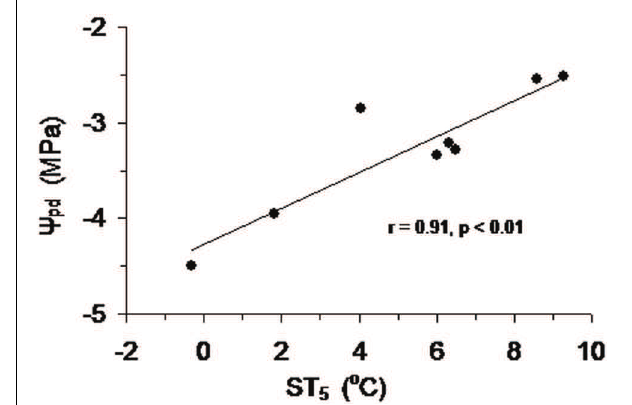
FIGURE 7 | Seasonal variation of predawn leaf water potential ( (cid:57) pd ) of Smith fir trees at the treeline sites. Different letters indicate significant differences in (cid:57) pd among observed dates at P < 0.05. Error bars indicate ± SD of mean.